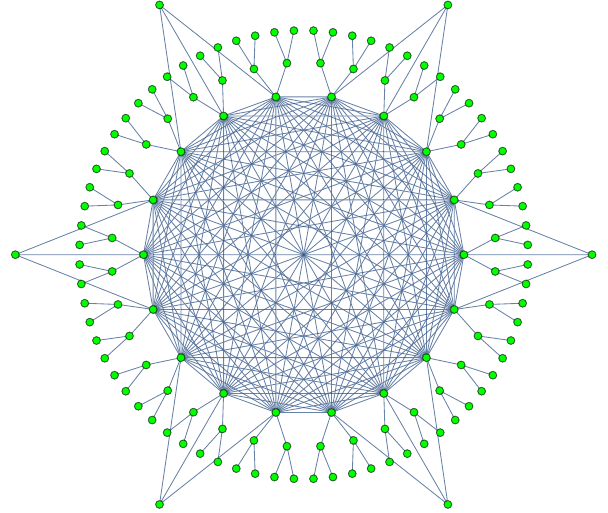
FIG. 6. A large repeater state with N ¼ 6 (logical qubits) proposed in Ref. [20], which includes subtrees in order to make the state more robust against errors.